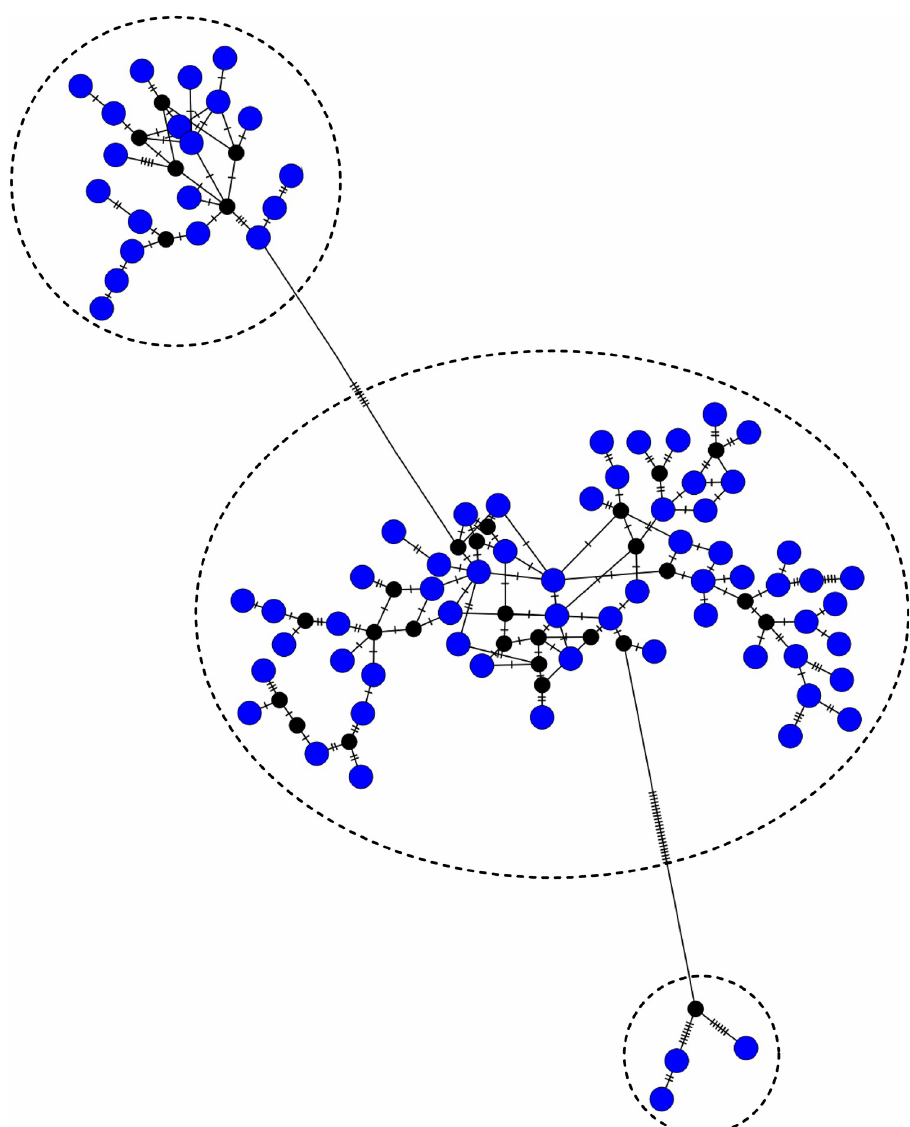
Fig 1. Haplotype map of the detected haplotypes of Andaman cattle. Dashed lines represent mutations. Network was drawn in PopART ver. 1.7